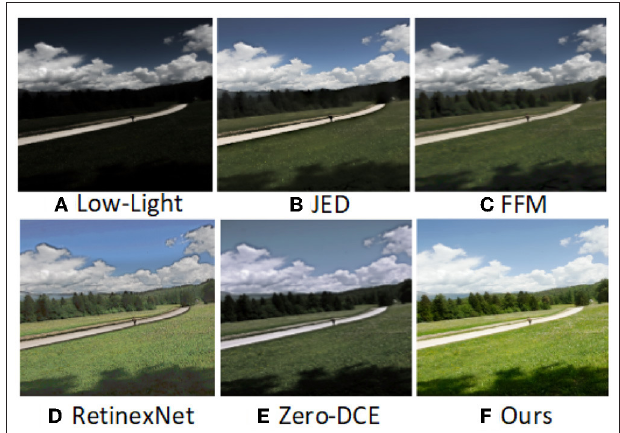
FIGURE 1 | (A) The input low-light image. (B-F) are the images enhanced using JED, FFM, RetinexNet, Zero-DCE, and the method of this article,